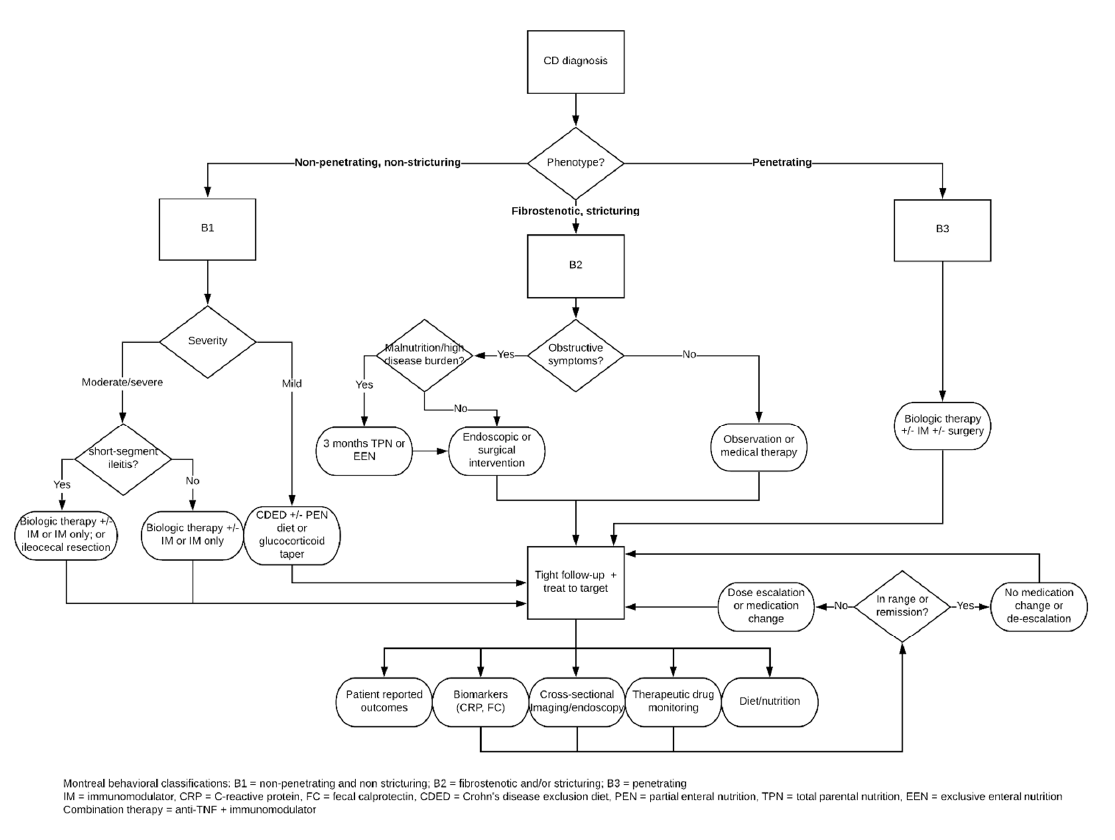
Figure 2. The new proactive algorithm.